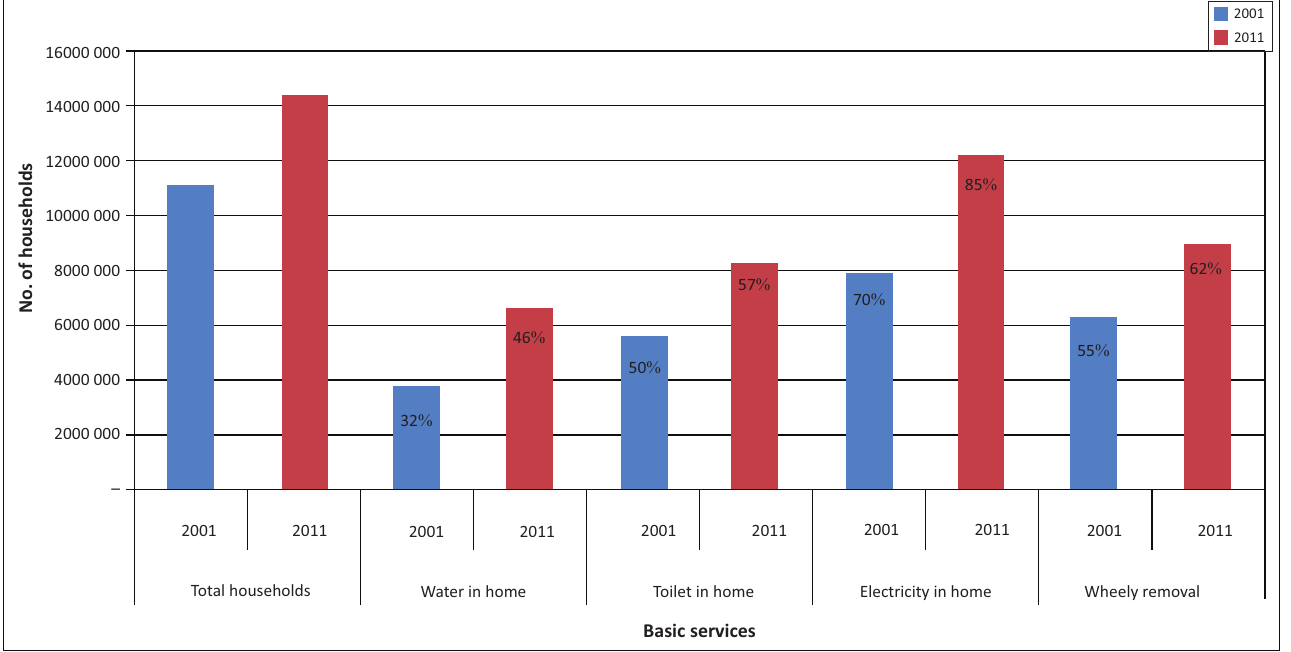
FIGURE 1: Access to basic